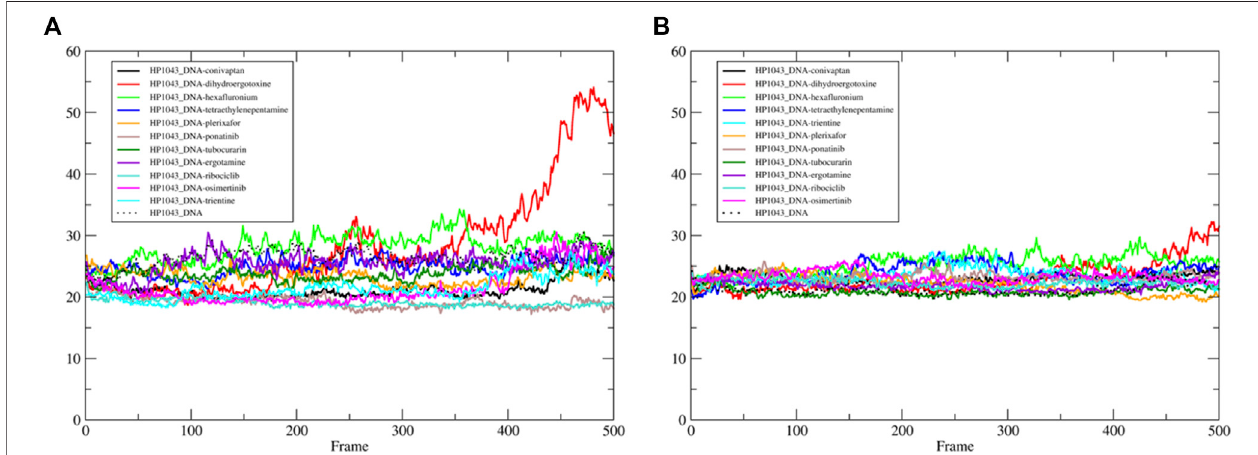
FIGURE 6 | HP1043 – DNA distance. Distance between A chain and DNA center of mass (A) and between B chain and DNA center of mass (B) .